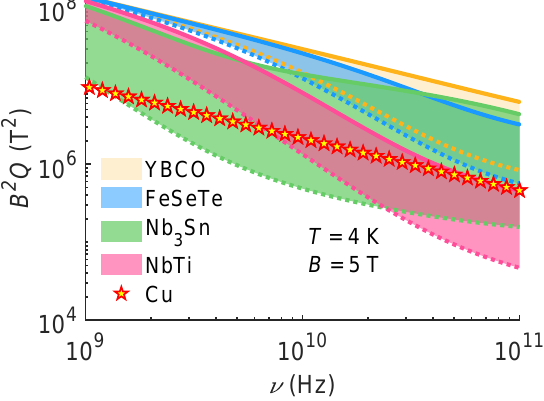
Figure 5. Comparison of the B 2 Q factors evaluated at 4 K and 5 T as a function of ν and keeping the same geometrical factors as in Section 3.1. The dotted lines represent the worst lower limit obtained in the B ⊥ J configuration. The continuous lines represent a more realistic situation, for which the α angular coefficient is taken into account, as is explained in the text. The ’star’ symbols represent the B 2 Q values obtained with a Cu cavity, the yellow area represents the values obtainable with YBCO, the light blue area represents those with FeSeTe, the green area represents those with Nb 3 Sn, and the red area represents those with